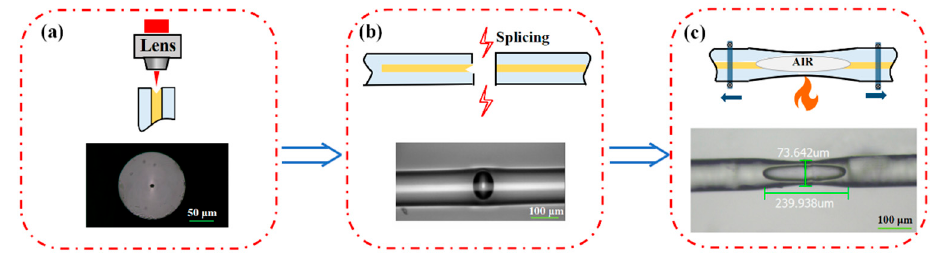
Figure 2. Fabrication process of the proposed sensing structure based on a hollow biconical fiber (HBF). ( a ) Micro-pit drilling by fs-laser, ( b ) Fusion splicing to form an inner air micro-cavity, and ( c ) Tapering by flame to form an HBF.